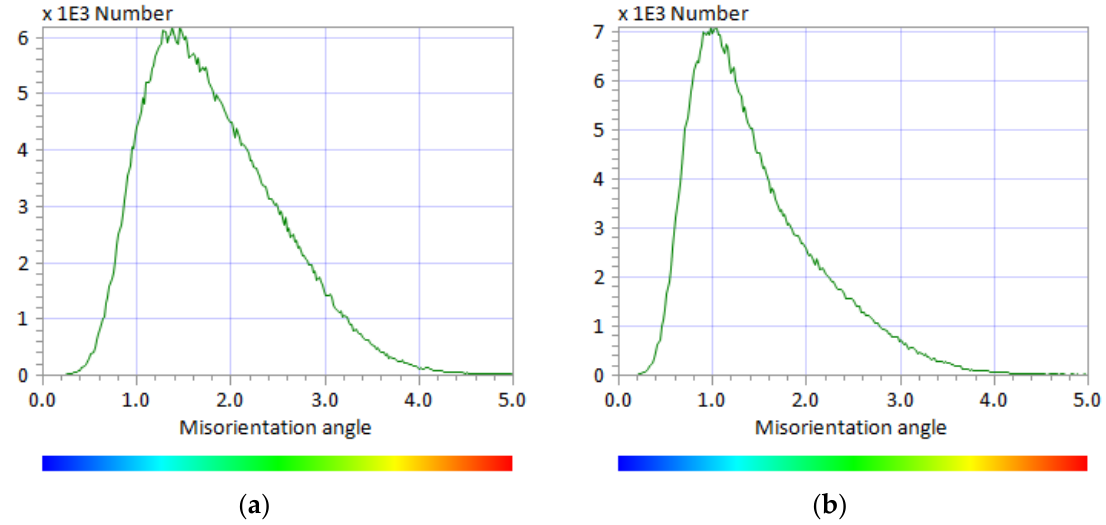
Figure 10. KAM changes on IC CGHAZ area during the four days of monitoring: ( a ) first day of monitoring and ( b ) fourth day of monitoring.